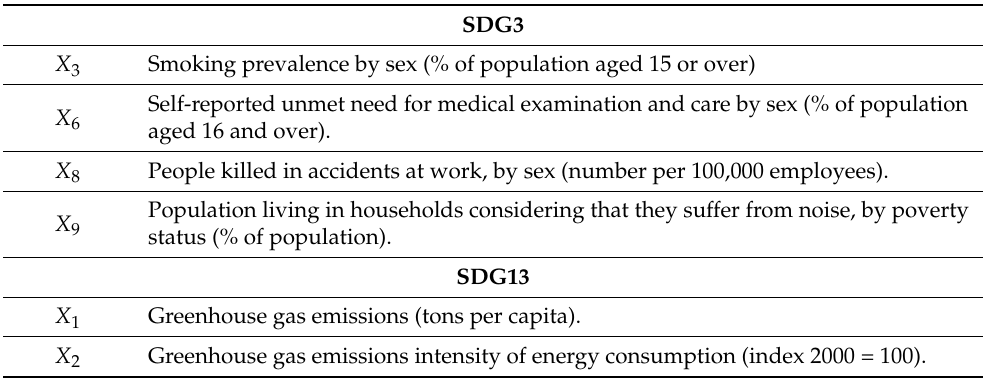
Table 4. Destimulants adopted in the